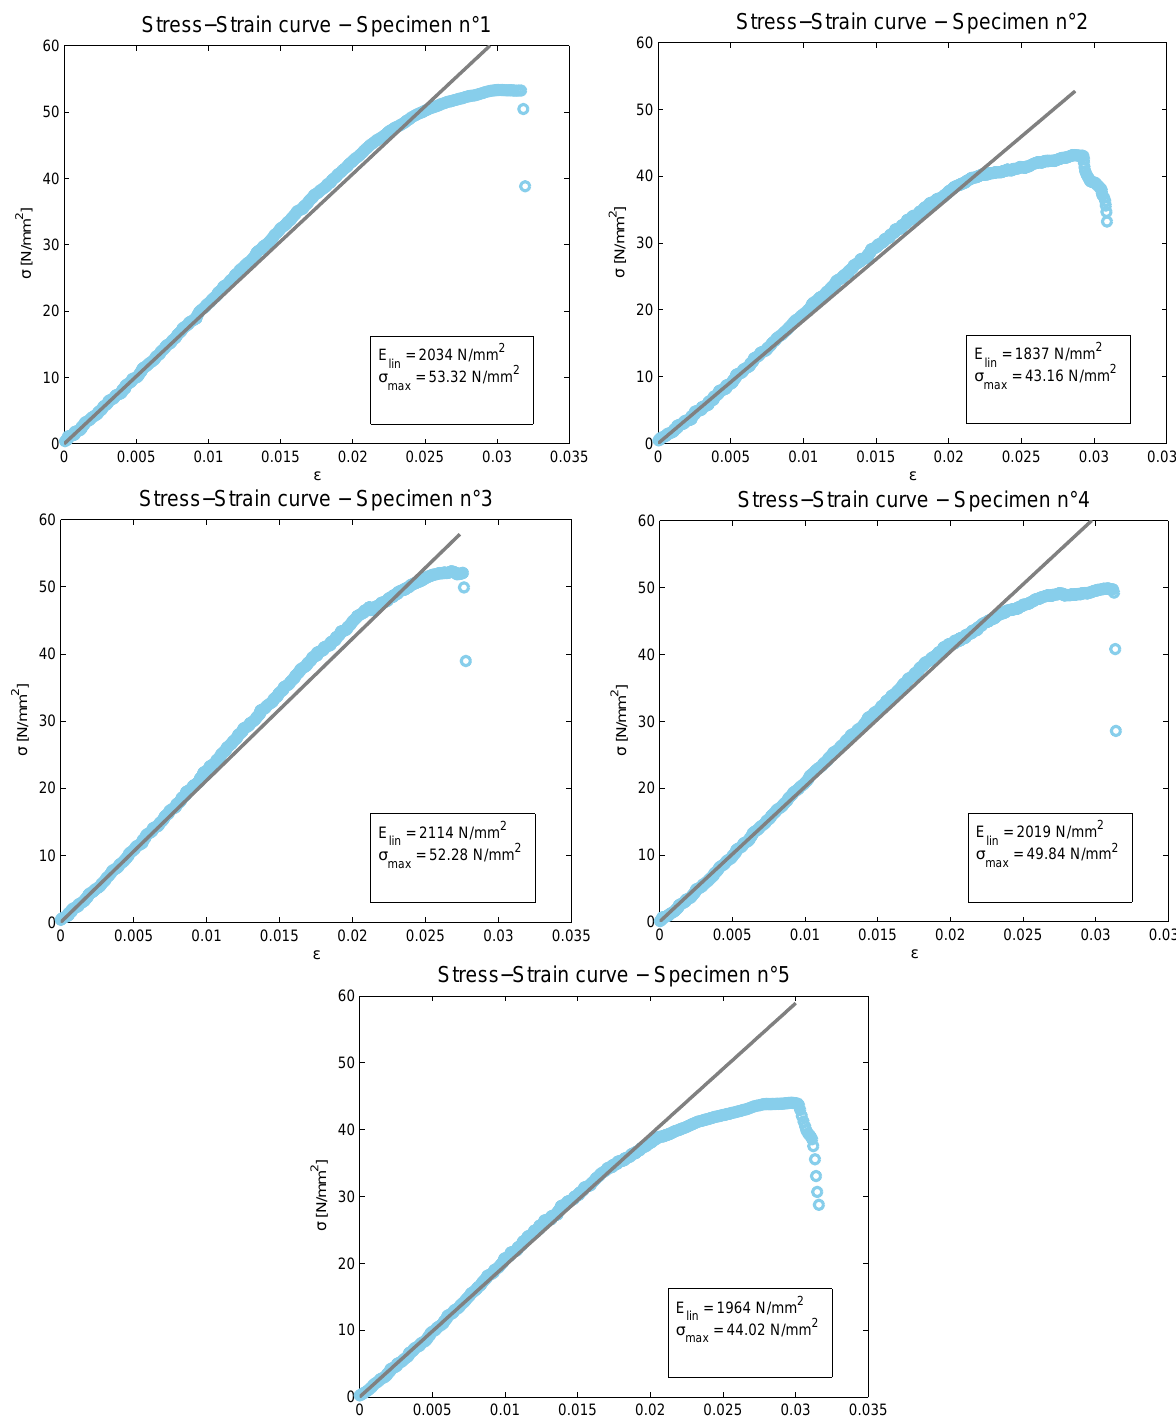
Figure 9: Stress-strain curves for specimens